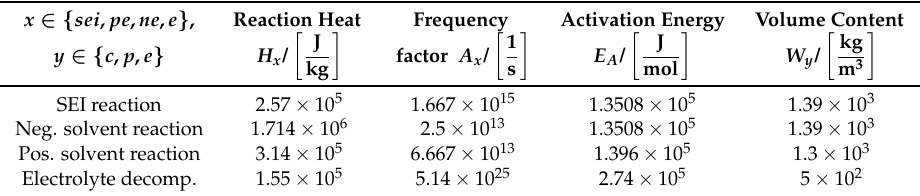
Table A2. Exothermic simulation